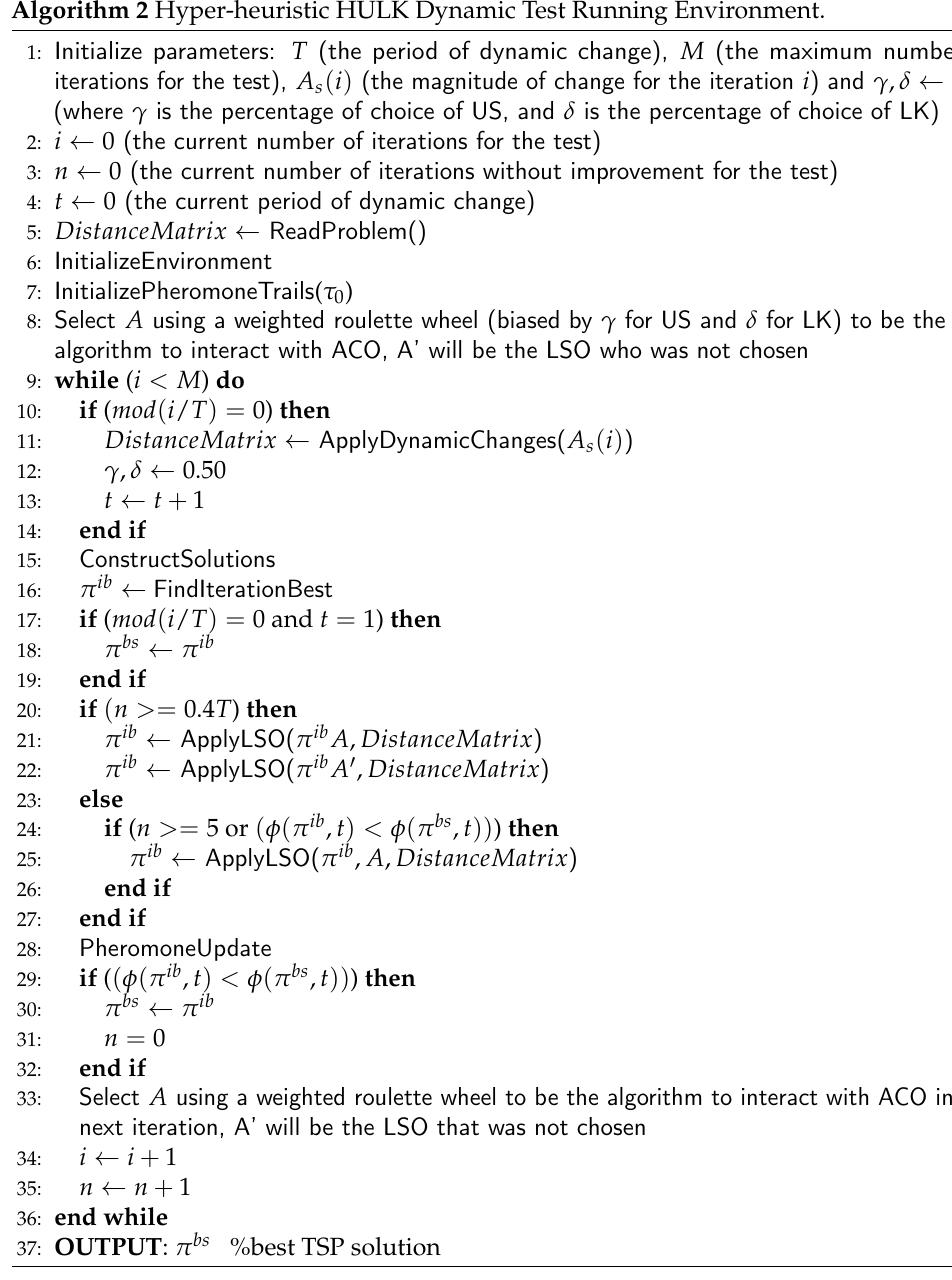
Algorithm 2 Hyper-heuristic HULK Dynamic Test Running